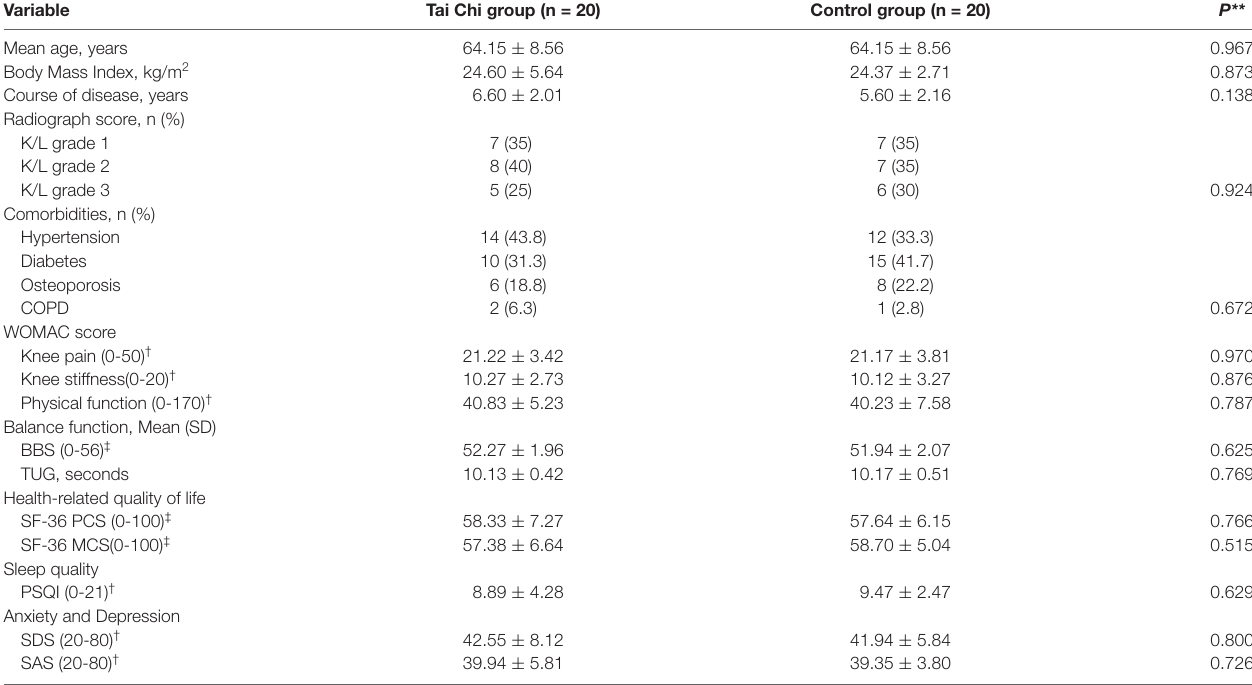
TABLE 1 | Baseline characteristics of